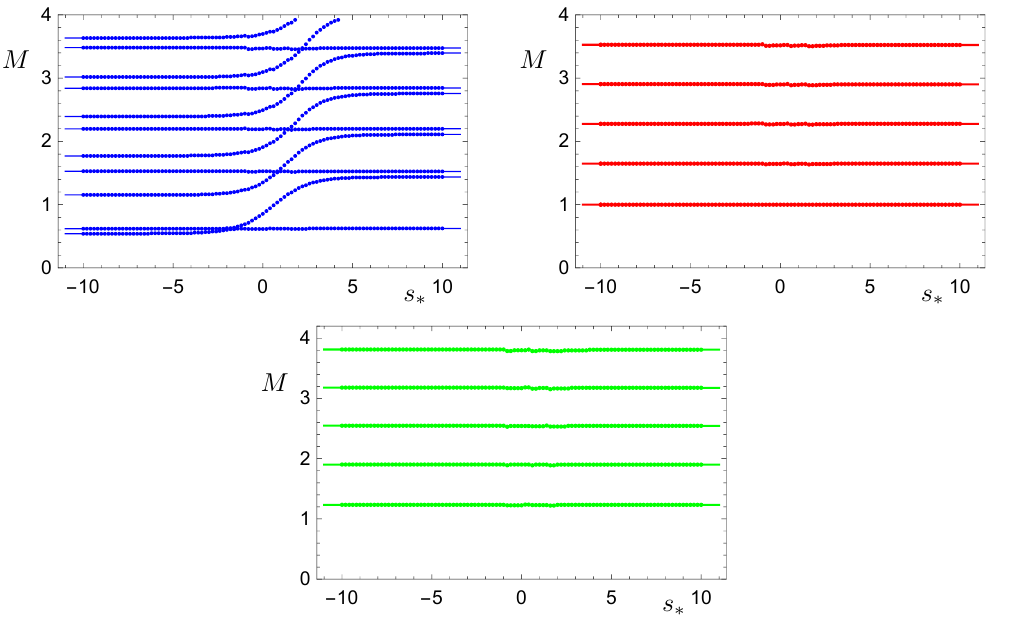
Figure 2 . The spectrum of masses M as a function of the scale s of the lightest tensor. In all plots, the left and right margins correspond to the spectra computed from the analytical solutions obtained by deforming the six-dimensional critical points. From top to bottom, left to right, the spectra of (cid:13)uctuations of the two scalars (cid:31) and (cid:30) (blue), tensors e (cid:22) (red) and the gravi-photon V (cid:22) (green). The numerical calculations are performed by setting the IR cuto(cid:11) to (cid:26) 1 = 0 : 001, and the UV cuto(cid:11) to (cid:26) 2 = 8. In the midpoint determinant method we set (cid:26) = (cid:3)